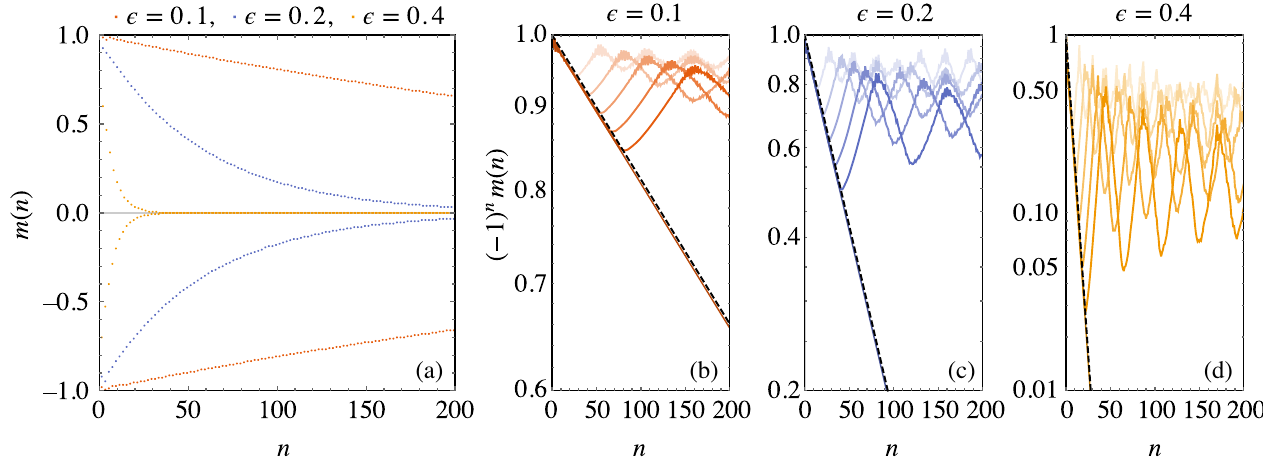
FIG. 3. (a) Evolution of the order parameter under the Floquet Ising dynamics in Eq. (6), with J ¼ 1 and different values of the kick strength ϵ . Data have been obtained by analytically solving the dynamics of the model, as explained in Appendix A. (b) – (d) Absolute value of the order parameter in logarithmic scale. Thick lines are the same data as in panel (a) and are for L ¼ ∞ . Shaded lines are the results of ED simulations for finite systems with different sizes L ¼ 10 , 15, 20, 25, 30, from lighter to darker colors. Dashed black lines denote the asymptotic exponential decay e − γ n , with γ predicted by Eq.